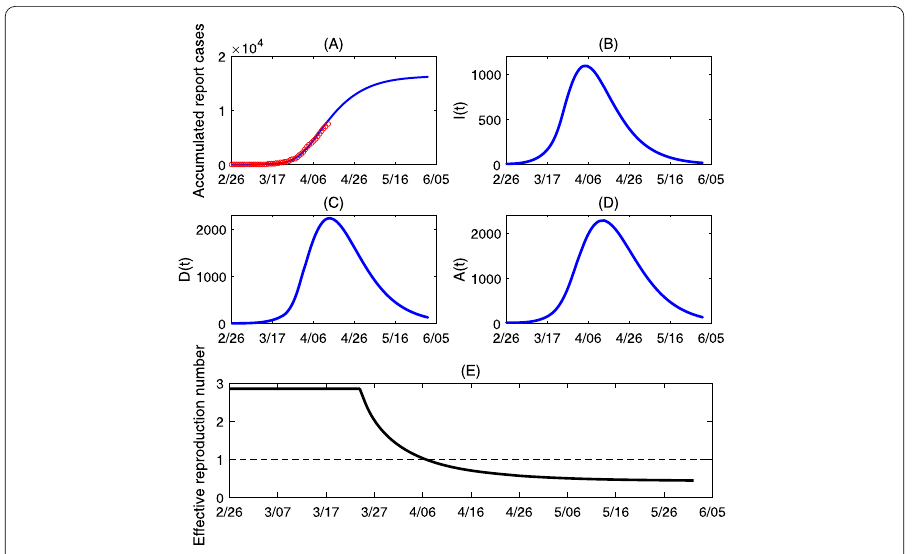
Figure 5 ( A ) Best model fitting result; ( B – D ) Solutions of model (1) by fixing the parameters as the estimated values; ( E ) Estimated effective reproduction number of